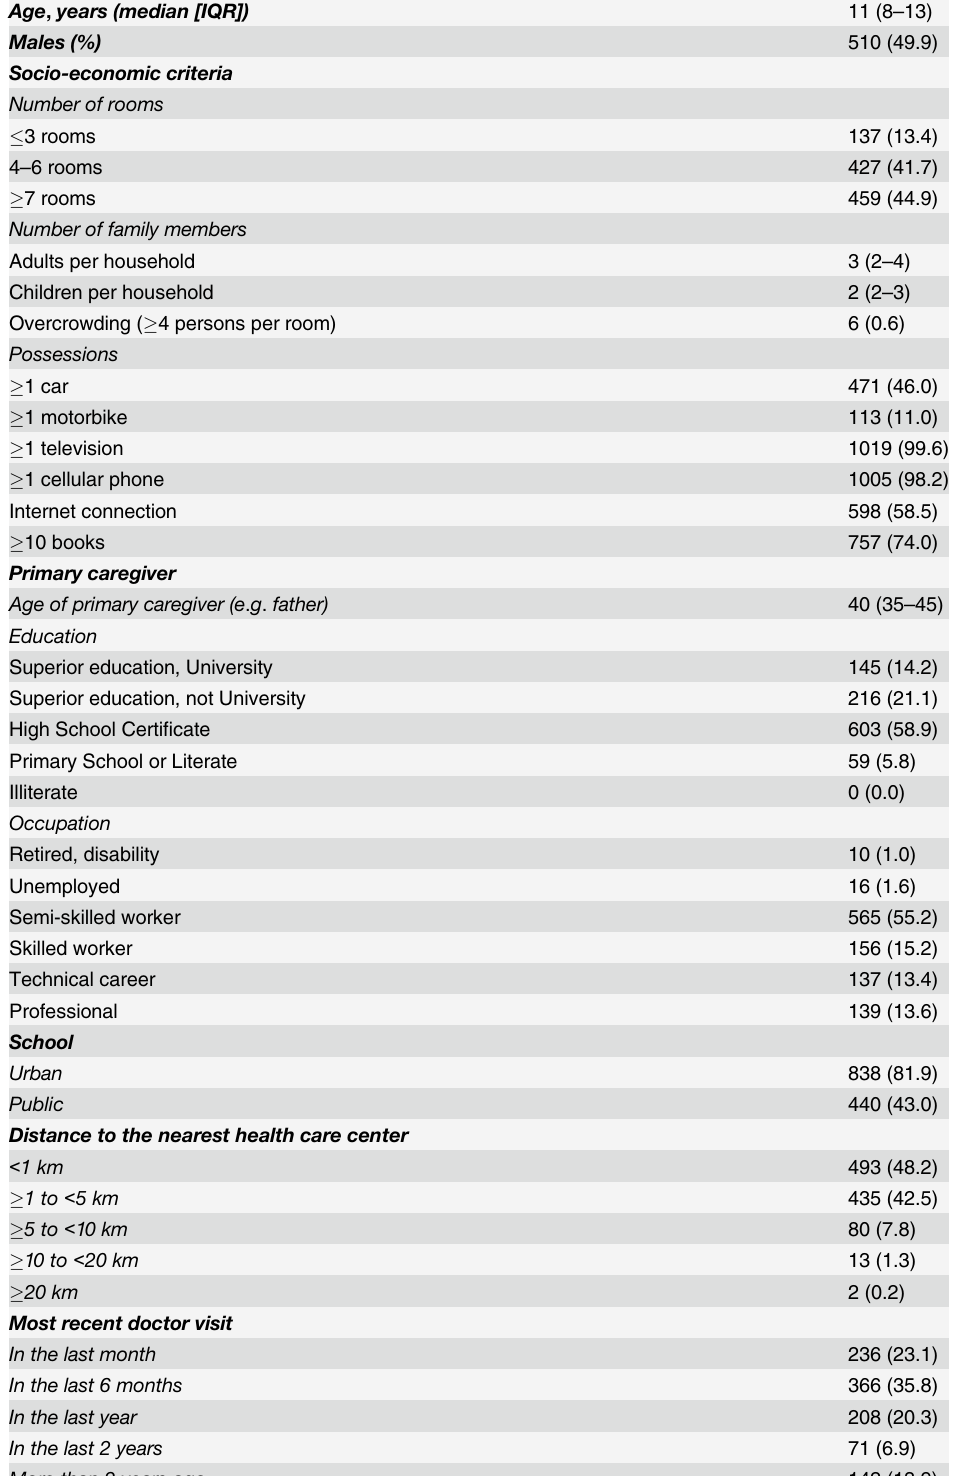
Table 1. Socio-demographic